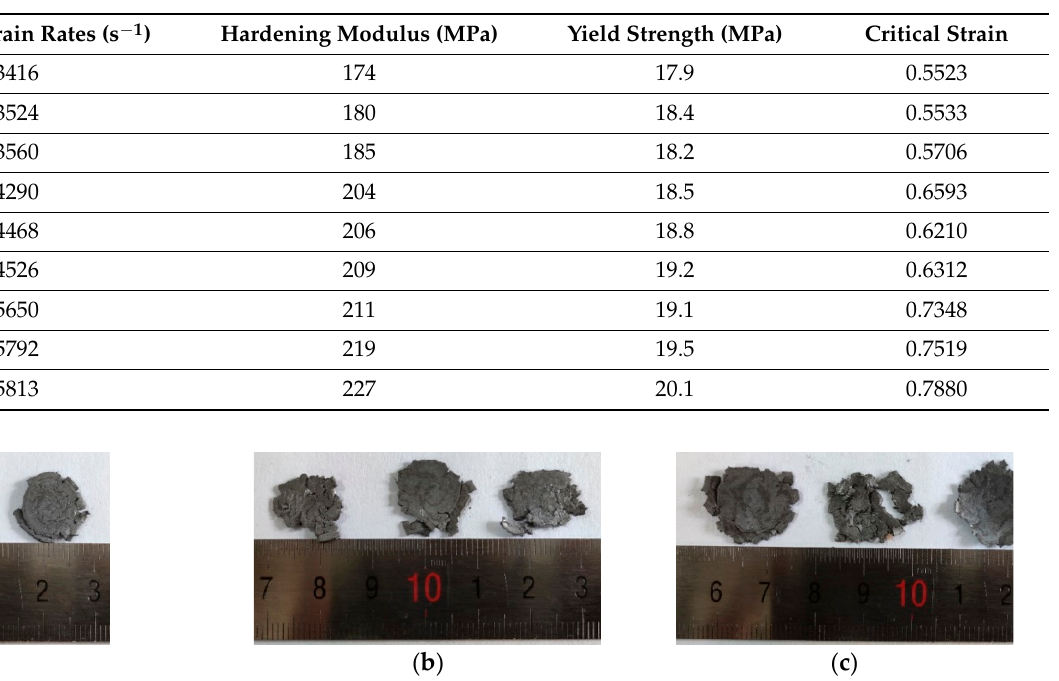
Figure 10. The recycled sample under different loading strain rates: ( a ) 3500 s − 1 ; ( b ) 4500 s − 1 ; ( c ) 5500 s − 1 .